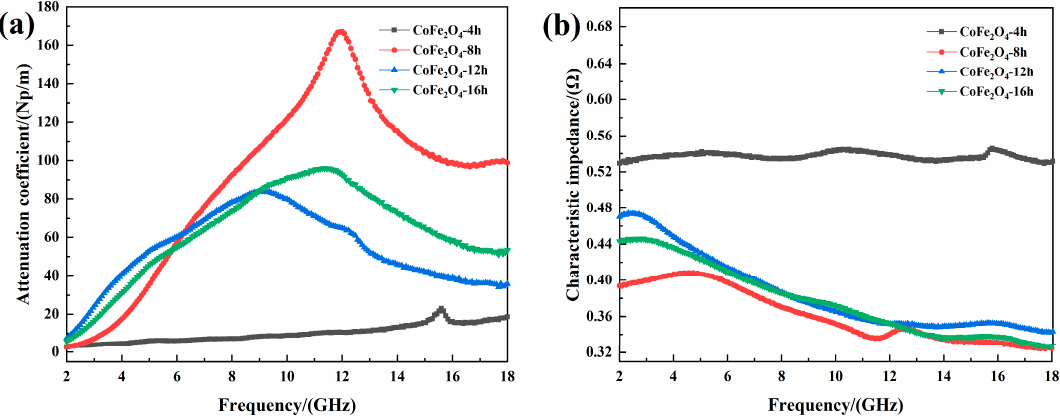
Figure 8. ( a ) Attenuation coefficient and ( b ) characteristic impedance of cobalt ferrite.